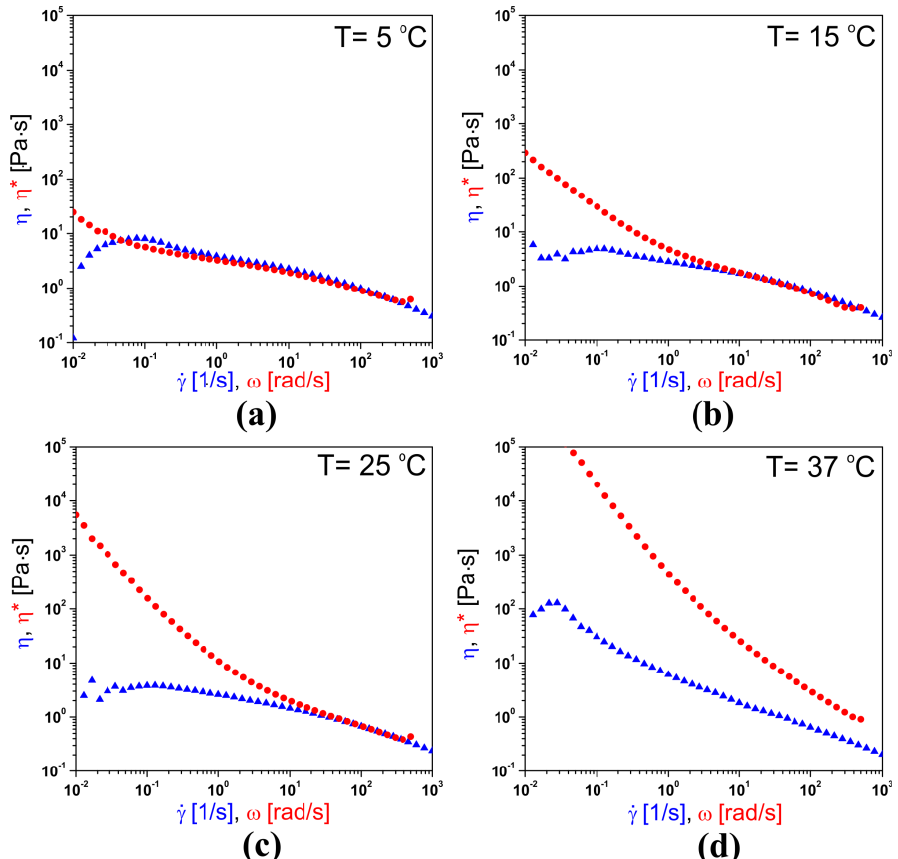
Figure 7. Experimental curves of dynamic viscosity and complex viscosity changes as a function of shear rate and angular frequency, respectively, at ( a ) 5 °C, ( b ) 15 °C, ( c ) 25 °C, and ( d ) 37 °C.